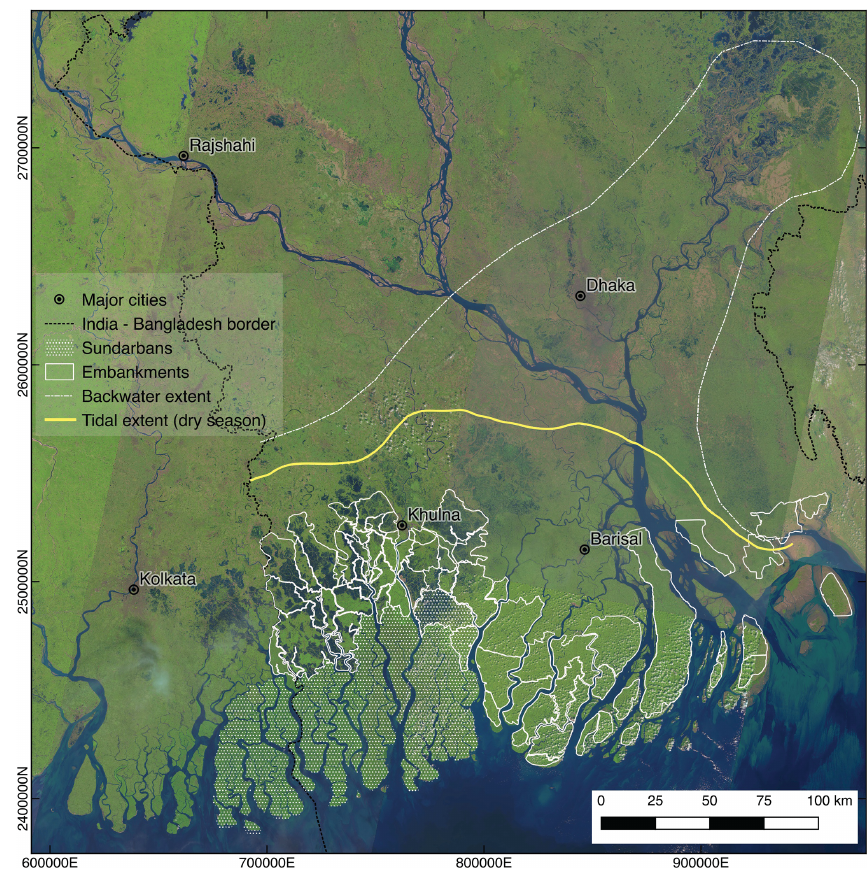
Figure 1. Overview map of the Ganges–Brahmaputra–Meghna Delta. Natural color shows the Landsat 8 OLI/TRS composite image from December 2018. Indicated on this map are polders (solid white lines), the Sundarbans mangrove forest (dotted white grid), the approximate dry season tidal limit (solid yellow line), and the dry season backwater extent (dash-dot white line) from mapped data of the Institute of Water